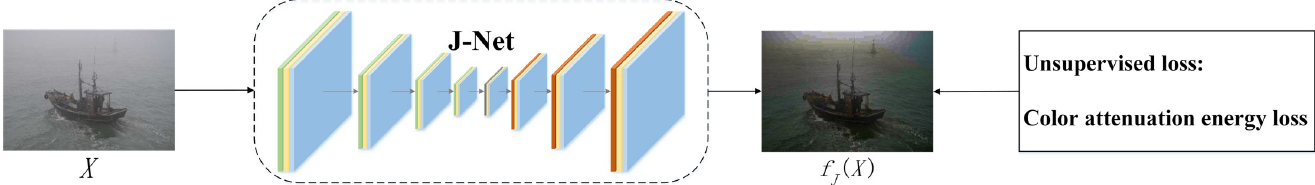
Fig 5. Clean image estimation branch, color attenuation energy loss is used for the constraint of network, the output of the network is a clean image with three- channel.